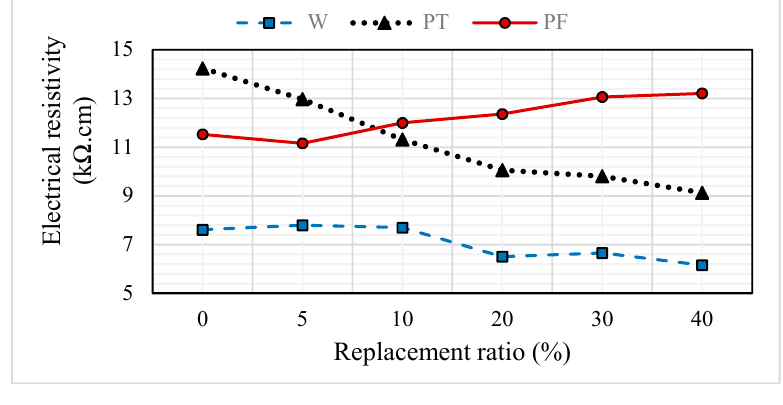
Figure 13. Relative f ctm of the concrete mixes at 28 days.